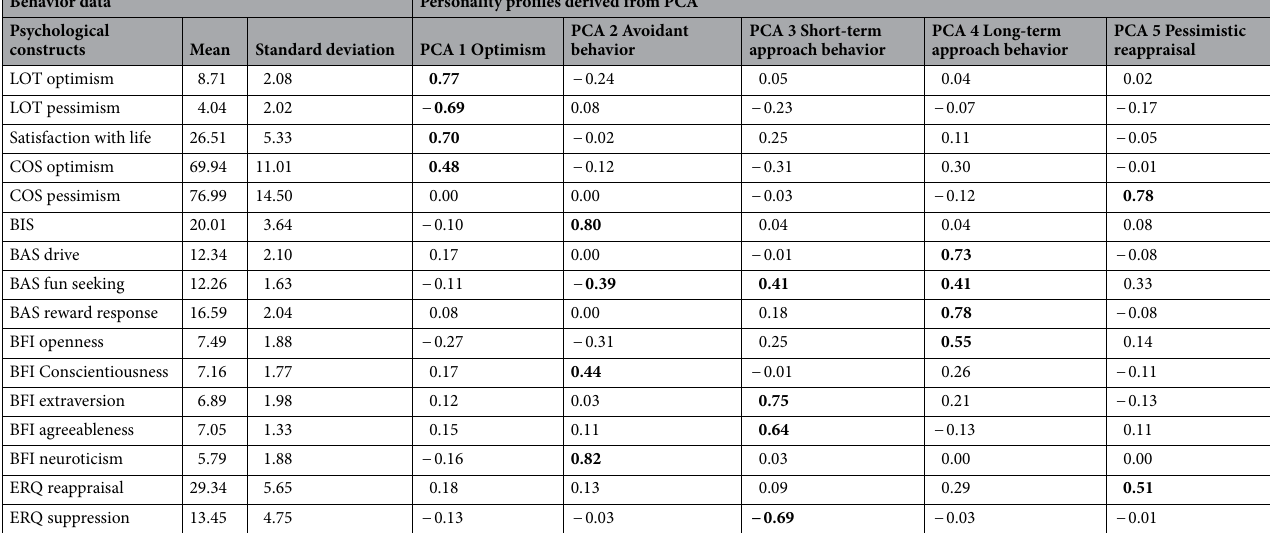
Table 1. PCA results derived from the questionnaire data. Descriptive statistics of mean and standard deviation of the behavioral questionnaires are presented. Bend correlations ‘rho’ between derived components and individual questionnaires are also provided. Bold indicates significant correlations (alpha = 0.05, corrected for multiple comparisons).